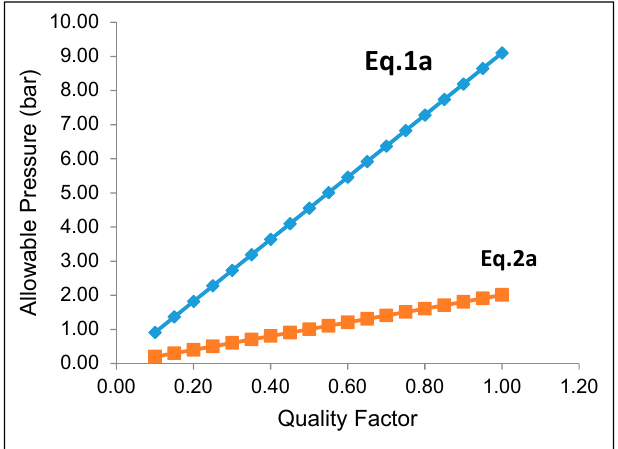
Figure 13. Allowable internal pressure as per ASME B31.3.